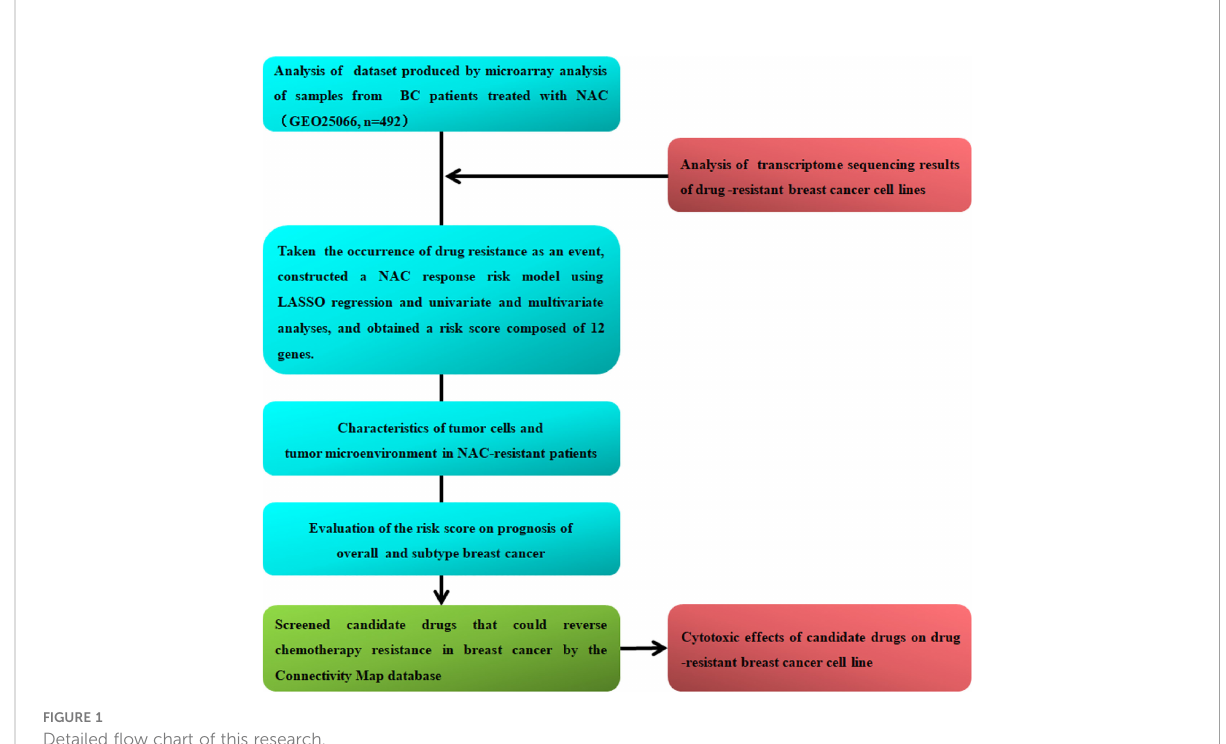
FIGURE 1 Detailed fl ow chart of this